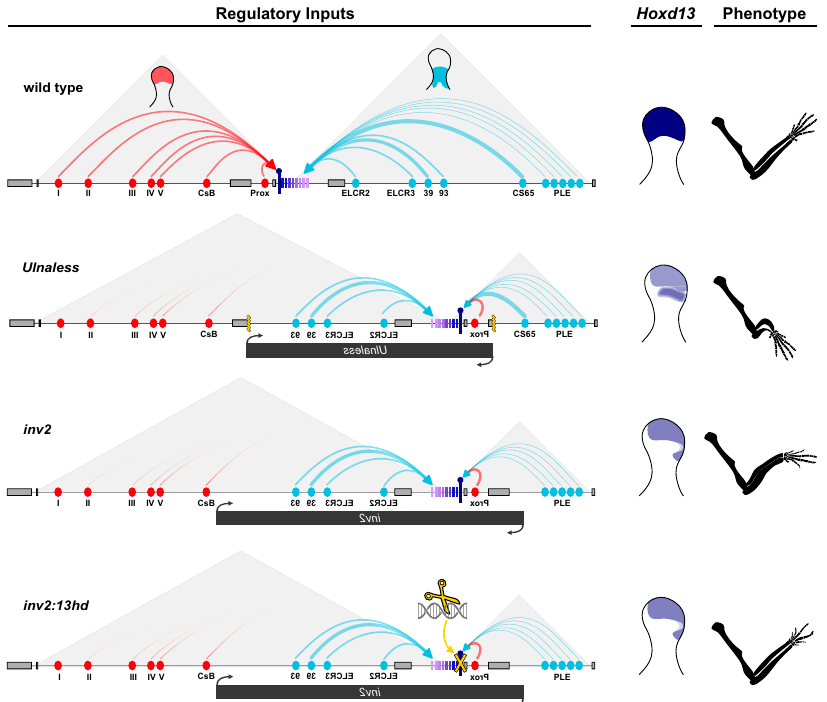
Fig. 5 Schematic illustrations of the regulations at work in the various mouse alleles and their effect on Hoxd13 expression. On top is the control landscape, with distal limb enhancers (red) activating Hoxd13 (purple pin) in distal cells. On the other side of the cluster, proximal limb enhancers (blue) regulate more telomeric Hoxd genes in proximal limb cells. As a result, Hoxd13 is expressed in distal cells only (right), leading to the wild type phenotype. In the Ulnaless inversion, Hoxd13 is positioned close to both a strong proximal enhancer (CS65) and a series of weaker enhancers (PLE). As a result, it becomes strongly expressed in proximal limb cells, while reduced in distal cells since it is separated from all distal limb enhancers except one (Prox), leading to a light phenotype in digits and strong mesomelic dysplasia. In the inv2 inversion, Hoxd13 is not adjacent to CS65 as in Ulnaless , but is now under the control of the weaker enhancer series (PLE). The gain of expression in proximal limb cells is weaker and accordingly, the mesomelic dysplasia is not as severe as in Ulnaless mice, while the digit phenotype is expectedly comparable. In inv2:13hd limb cells (bottom), the transcription of Hoxd13 hd is the same as in inv2 , yet the mesomelic dysplasia phenotype is completely rescued and the forearms are like wild type. However, because Hoxd13 is now fully inactivated in distal cells, the digit phenotype is stronger and equivalent to a full Hoxd13 knock-out 30 illustrated by the total amount of detected peaks, this shift in proportions indicates a change in the binding repertoire towards a condition intermediate to interfering with HOXA11-binding sites and deployment of a distal limb program in the proximal limb cells. This is corroborated by the scRNA-seq experiment where the cells of proximal limb did not show a complete transition to distal limb cell identity.